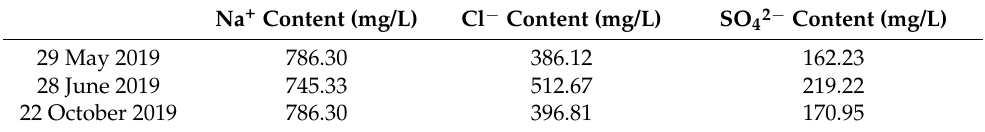
Table 3. Anion and cation content of the desalination buffer in NH.W2 in May, June and October 2019. Na + Content